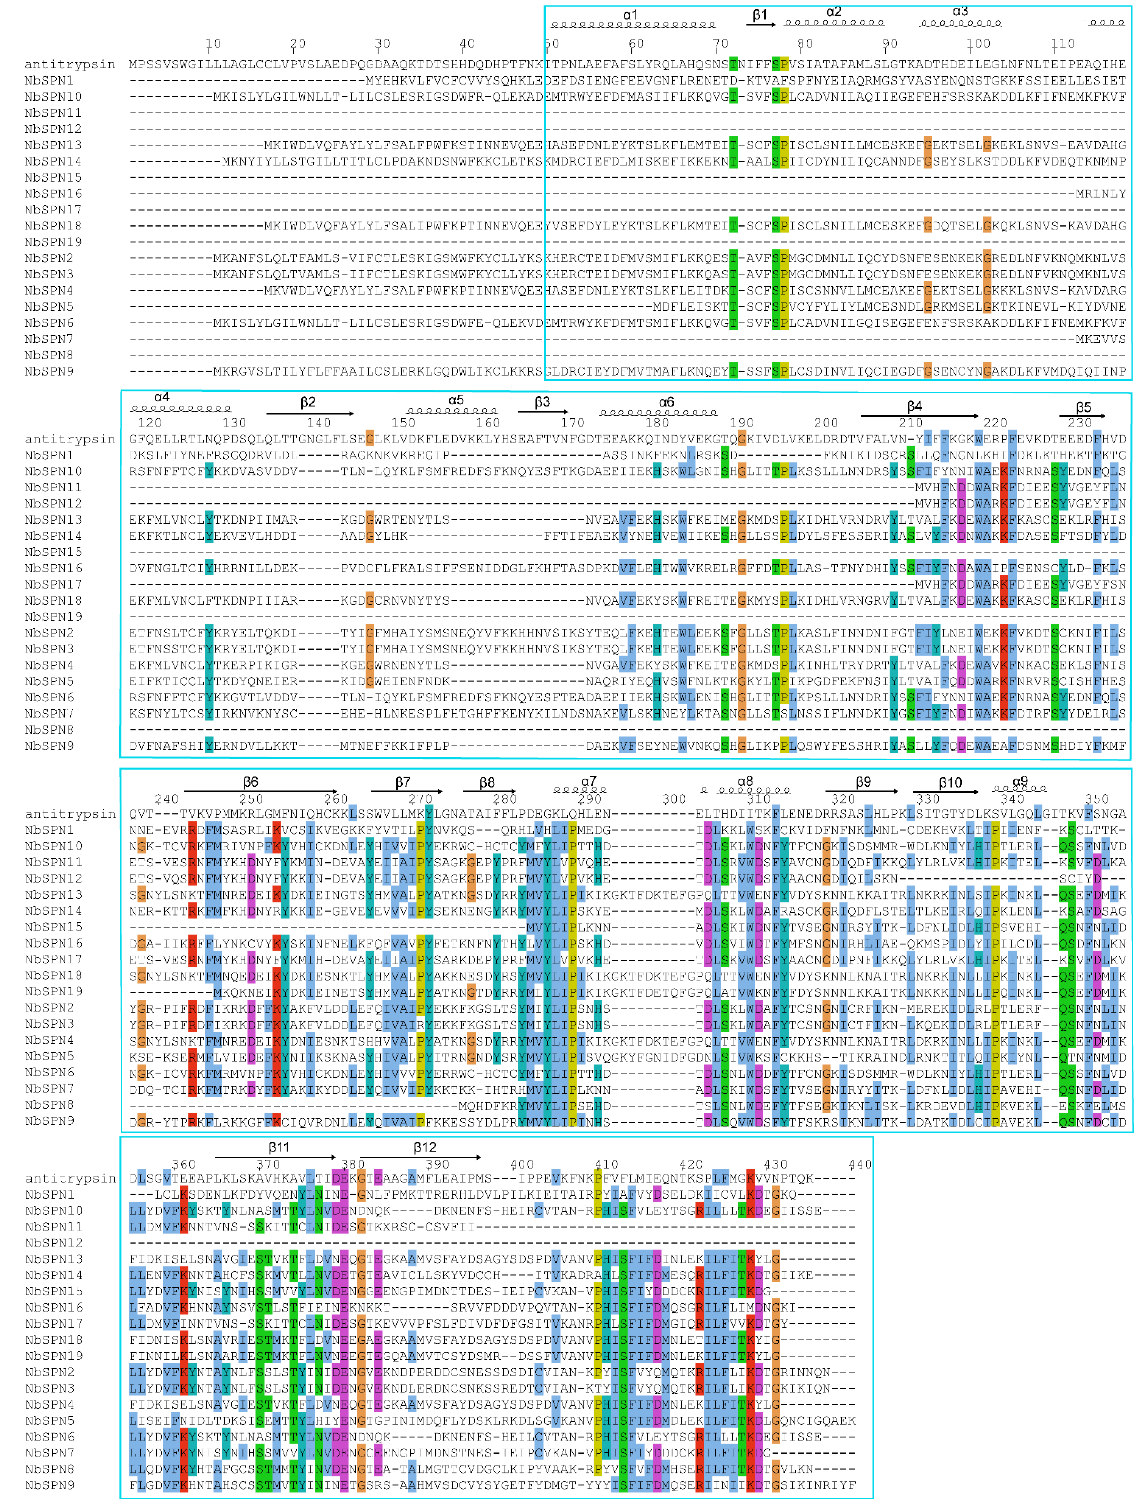
Figure 1. Multiple sequence alignment of all NbSPNs in Nosema bombycis . A blue box marks the typical conserved serpin domain. Human α 1-antitrypsin (1QLP) with “template” numbering and the assignment of secondary structures of the cleaved form are included as the top sequence. The alignment of sequences was conducted with ClustalX and shaded with ESPript 3.0 online. Residues were considered as highly similar and are colored in red and framed in